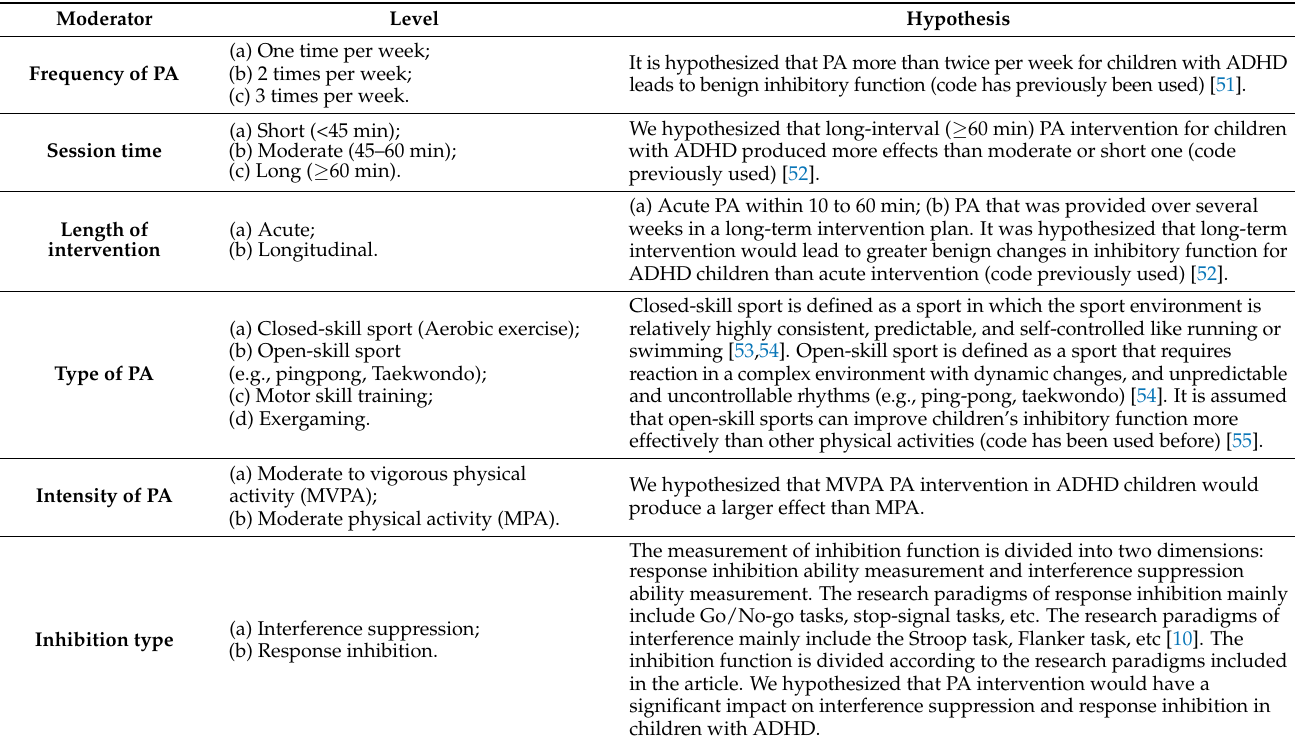
Table 2. Selection of intervention characteristics as